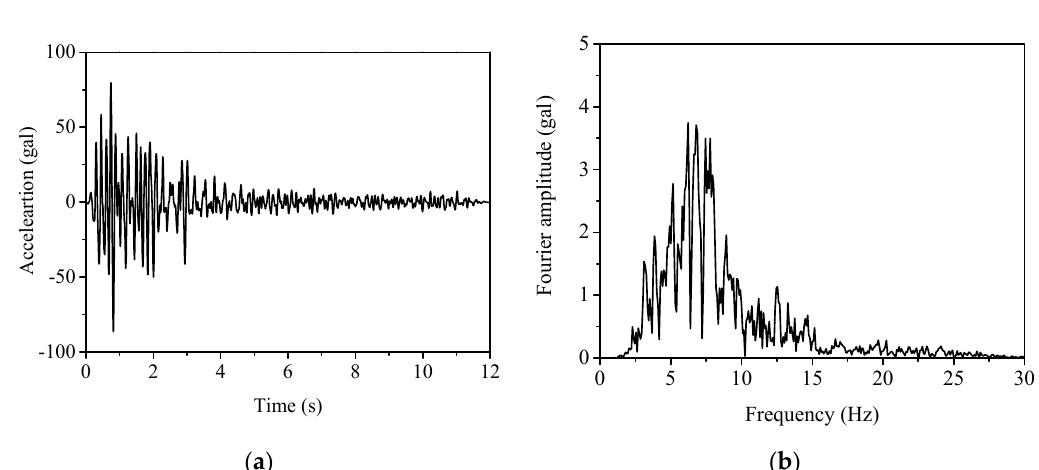
Figure 16. ( a ) Acceleration record of the Whittier Narrows–02 seismic wave and ( b ) its Fourier spectra.